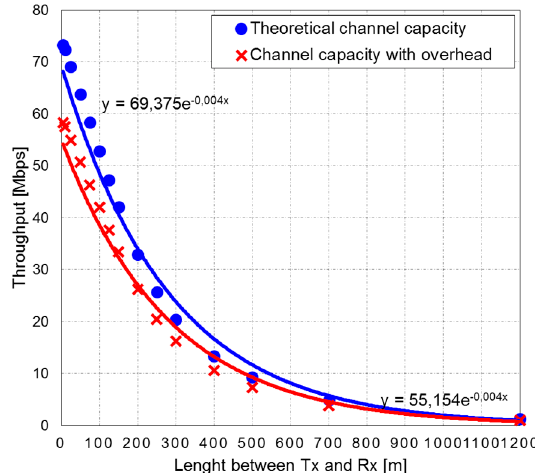
Figure 4. Channel capacity for NAYY150SE cable with varying length from transmitter to receiver.